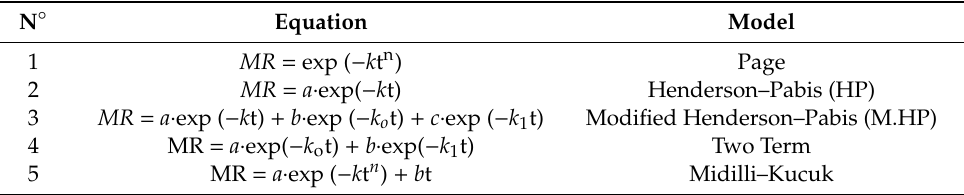
Table 1. Thin-layer drying mathematical